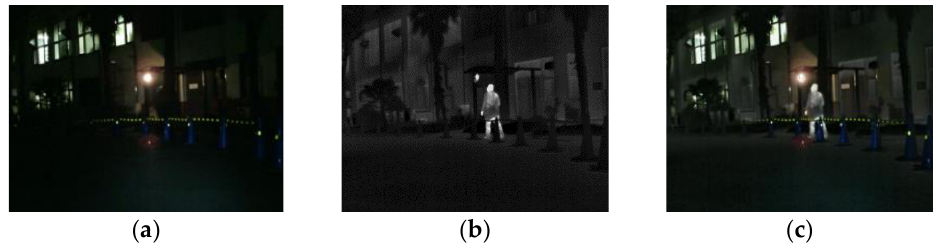
Figure 6. Image fusion in the robot vision field: ( a ) infrared image; ( b ) visible light map; ( c ) fusion image.